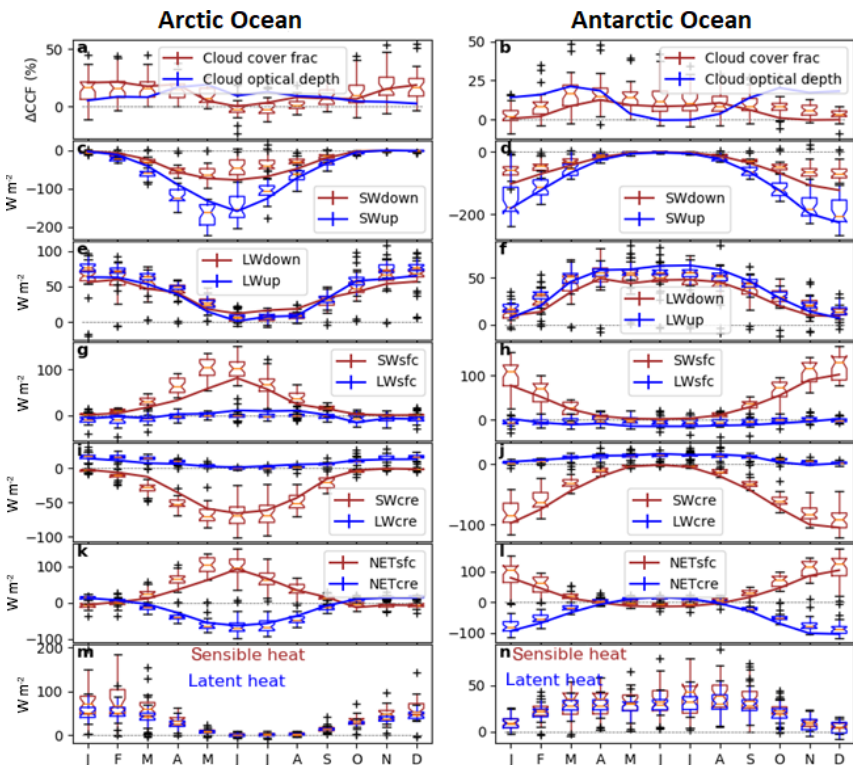
Figure 8. Monthly change in different terms of the radiative energy balance, cloud optical depth (COD) and cloud cover fraction (CCF) extrapolated from observations for a hypothetical 100% decrease in SIC over the areas where SIC change was observed during the period 2001–2016. This estimate came from the use of a linear interpolation of the change of different parts of the energy budget, COD and CCF as a function of a change in SIC coming from all possible combinations of couplets of consecutive years for a given month from 2001 to 2016, and for all grid cells for which SIC is larger than zero in 1 of the 2 years (see Sect. 2.7). CERES data are shown by solid lines (the standard deviation of the slopes are also reported but are too small to be visible), while CMIP5 models are shown by boxplot, and the box (in the same colour as observations) represents the first and third quartiles (whiskers indicate the 99% confidence interval, and black markers show outliers). In order to use the same scale, COD has been multiplied by a factor